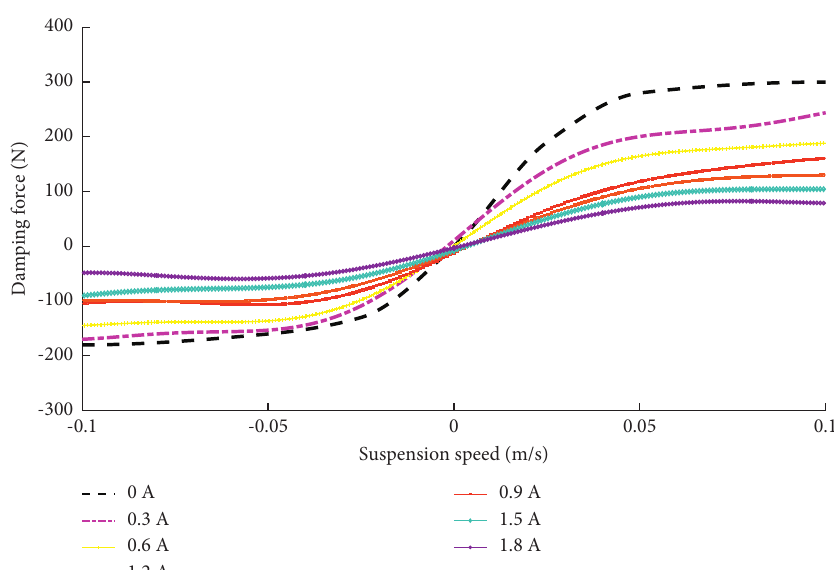
Figure 6: Regression fitting curves of the velocity characteristic